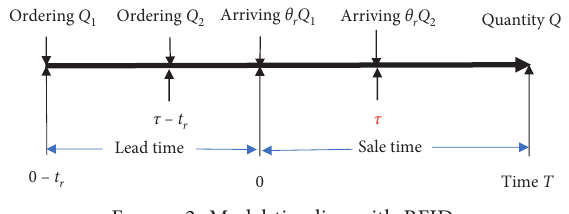
Figure 2: Model timeline with